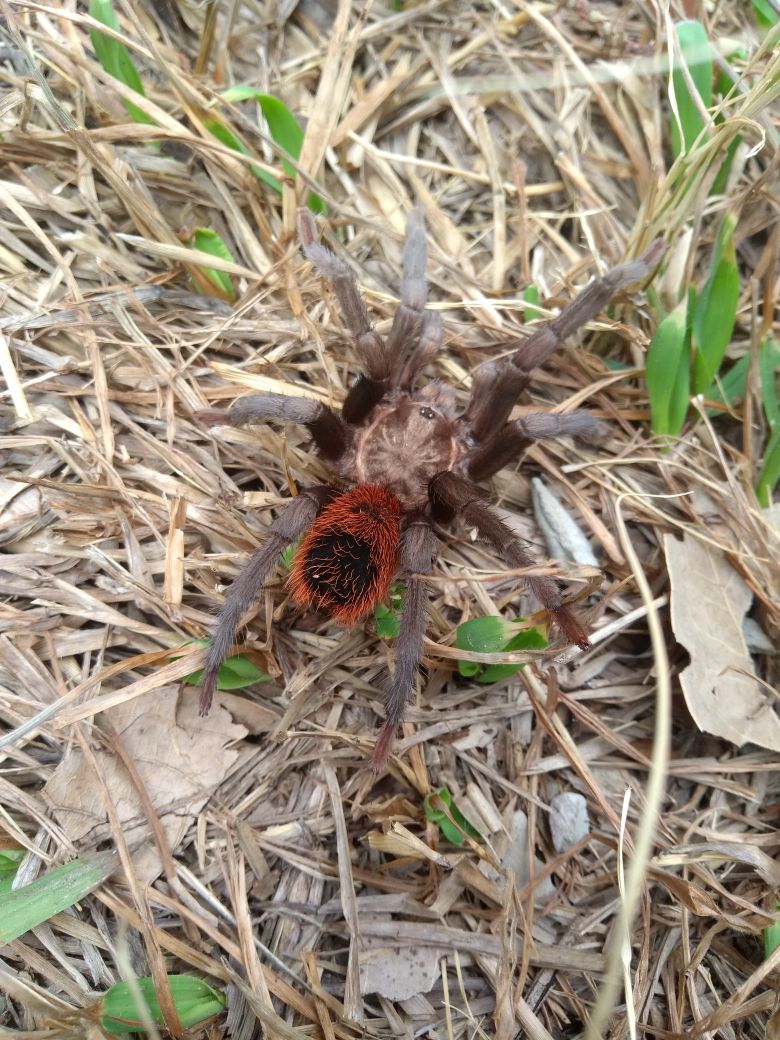
Brachypelma
epicureanum (Chamberlin, 1925) male from Mexico. Photo: Rodrigo Orozco.